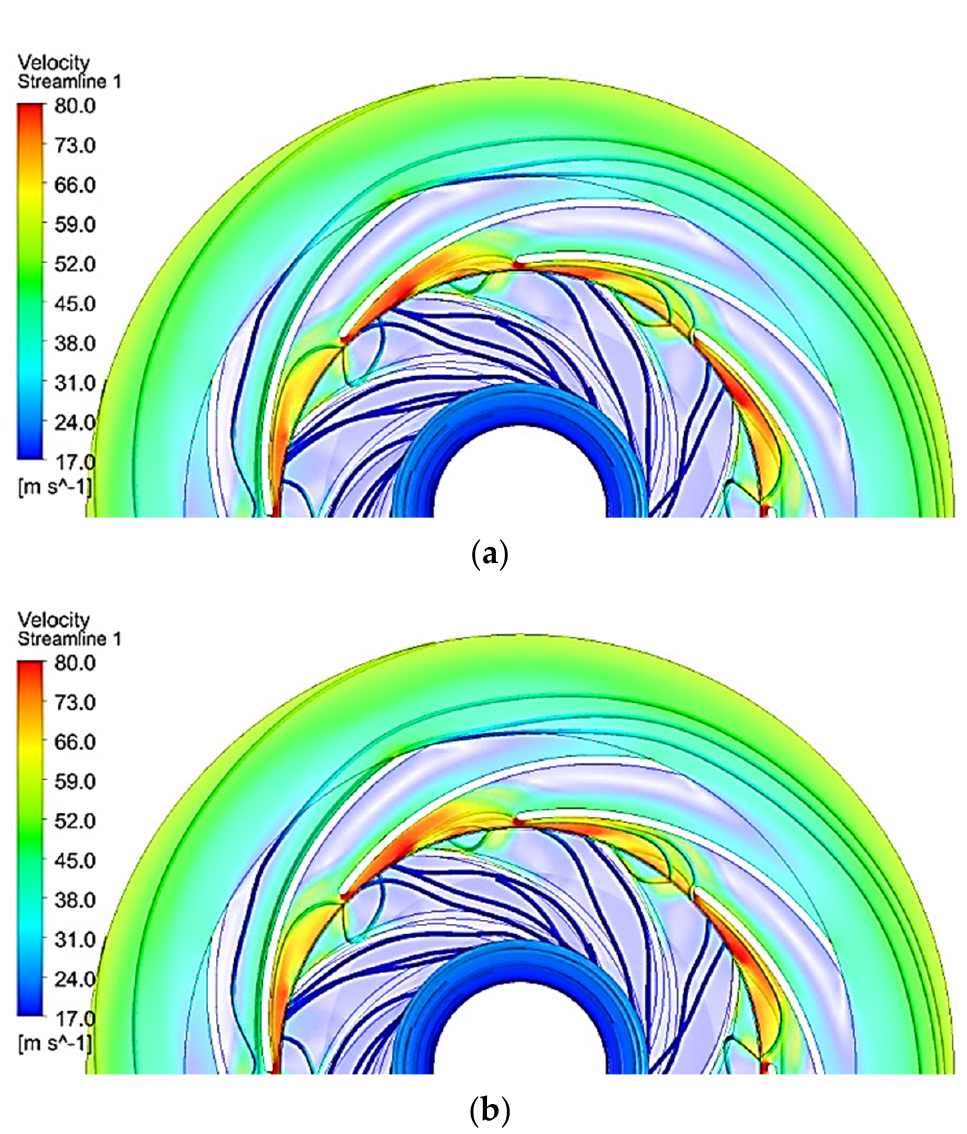
Figure 4. Stages with trimming of 5 mm: ( a ) D 4 = c о nstant; ( b ) h = c о nstant.